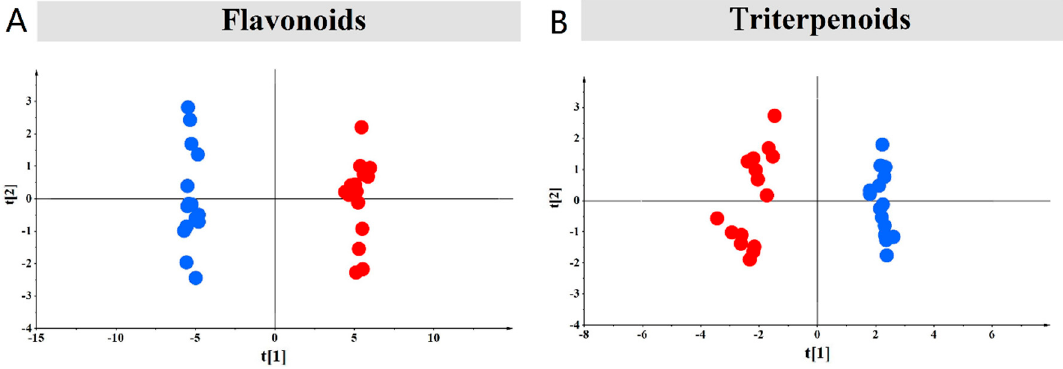
Figure 3. Principal component analysis of ABA-treated and CG samples based on the content of the 41 flavonoids and 10 triterpenoids. ( A ) Represents the PCA of flavonoids; while ( B ) represents the result of triterpenoids. Red points represent the ABA-treated samples, and blue points represent the CG samples.